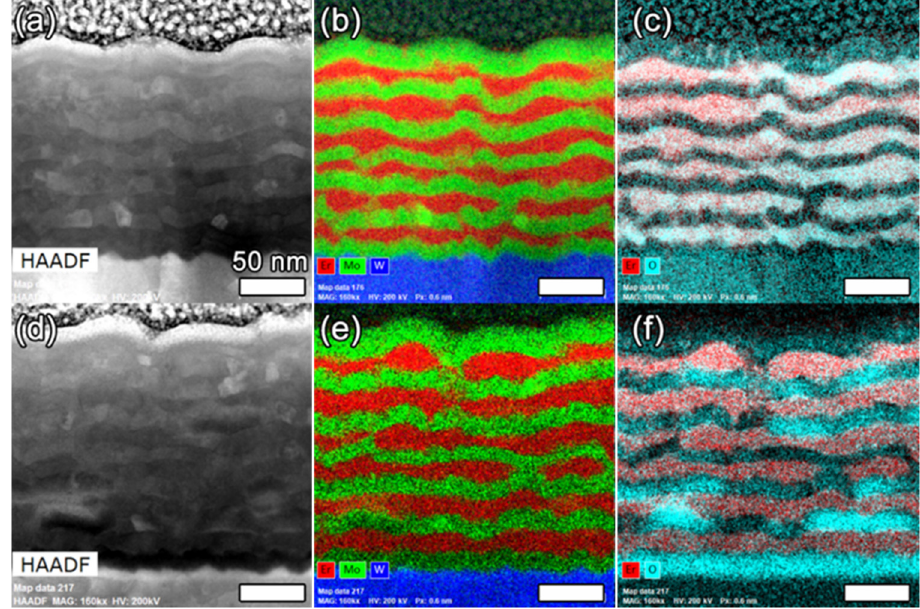
Figure 1. EDXS maps showing the nanolayers ( a – c ) before and ( d – f ) after hydriding. Overlays of the O and Er EDXS maps in ( c ) and ( f ) show the correspondence between these elements, which are indicative of Er oxide formation supporting the XRD spectra and show the presence of Er 2 O 3 .